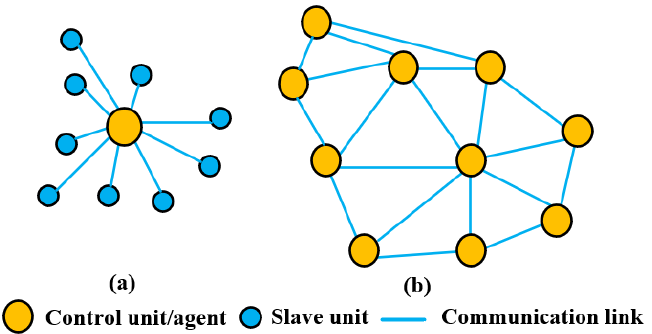
Figure 1. A graphic view of ( a ) centralized methods and ( b ) distributed schemes.